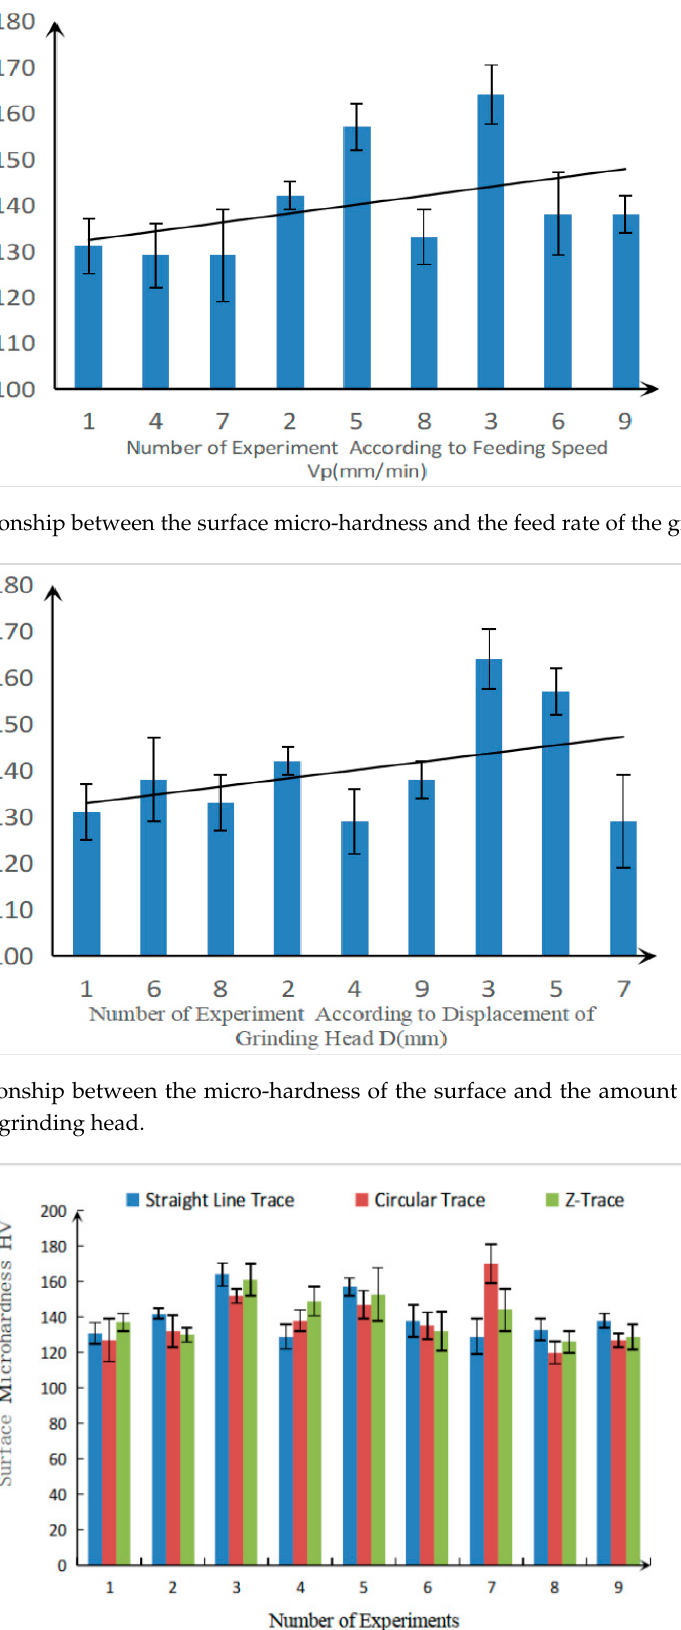
Figure 18. Relationship between the surface micro-hardness and the belt line speed.